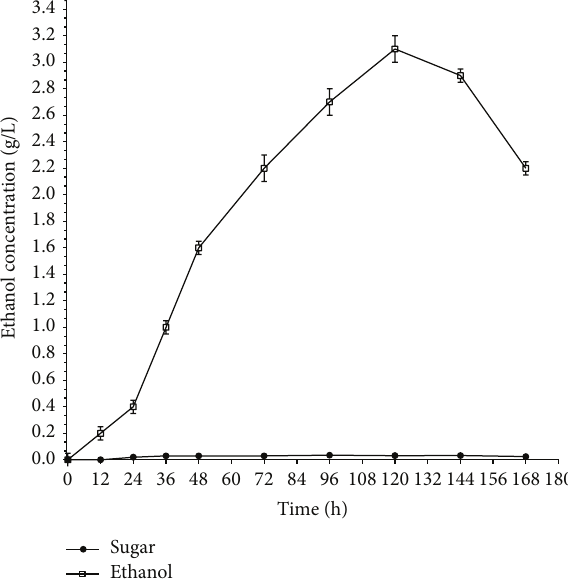
Figure 4: Time course of ethanol production by HJ48 and CICC40360 using 50 g/L sugarcane bagasse as the sole carbon